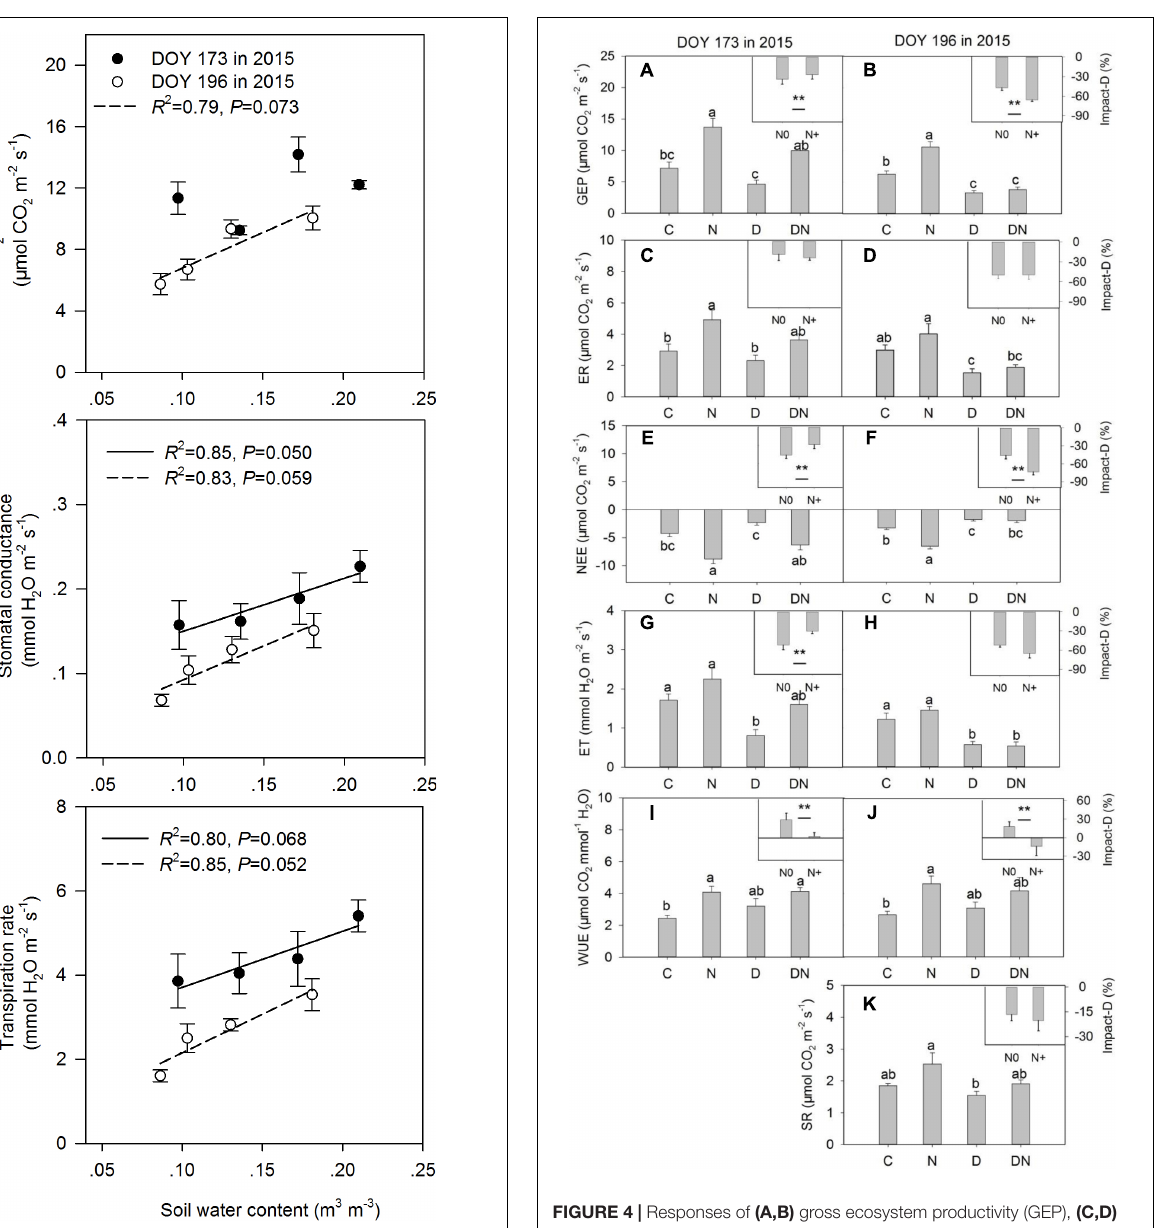
FIGURE 4 | Responses of (A,B) gross ecosystem productivity (GEP), (C,D) ecosystem respiration (ER), (E,F) net ecosystem CO 2 exchange (NEE), (G,H) evapotranspiration (ET), (I,J) water-use efficiency (WUE), (K) soil respiration (SR) to four treatments (C, control; N, nitrogen addition; D, drought; DN, nitrogen addition plus drought) at the middle (DOY 173) and the end (DOY 196) of the drought period. Impact-D = ( X D – X C )/ X C × 100, or = ( X DN – X N )/ X N × 100, where X indicates GEP, ER, NEE, ET, WUE, and SR. Different letters and asterisk indicate significant differences between the treatments ( P < 0.05). The error bars represent standard errors of means ( n =